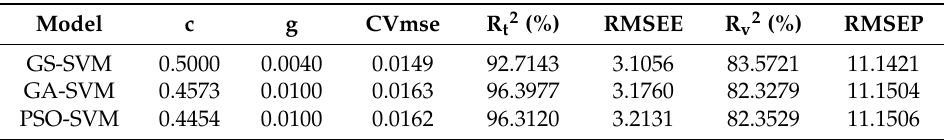
Table 6. Statistics of the SVM models.